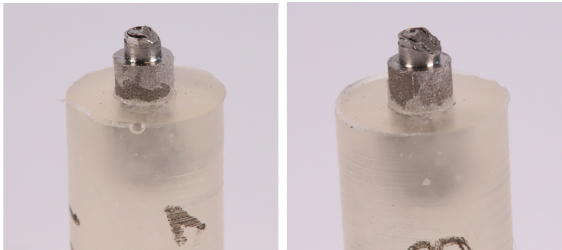
Figure 5. Two EH specimens after mechanical tests. The images show failure of the specimens right be- low the head of the abutment screw. Note that all specimens failed exactly in this manner.